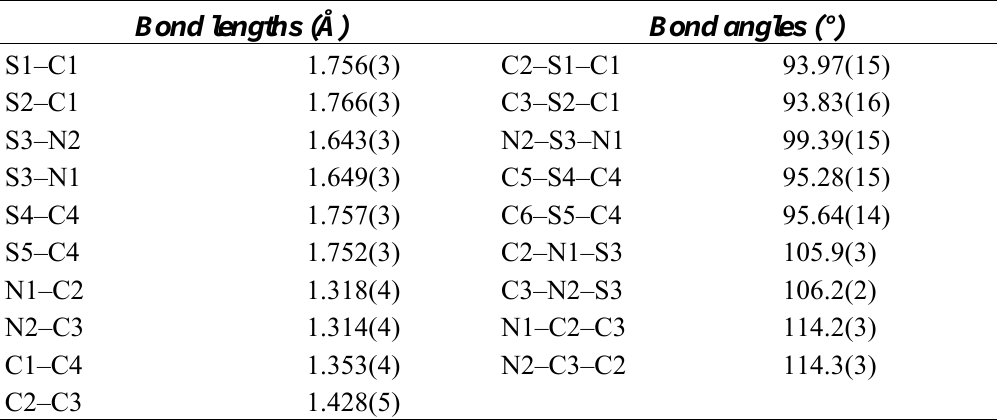
Table 1. Selected geometric parameters of 1 .